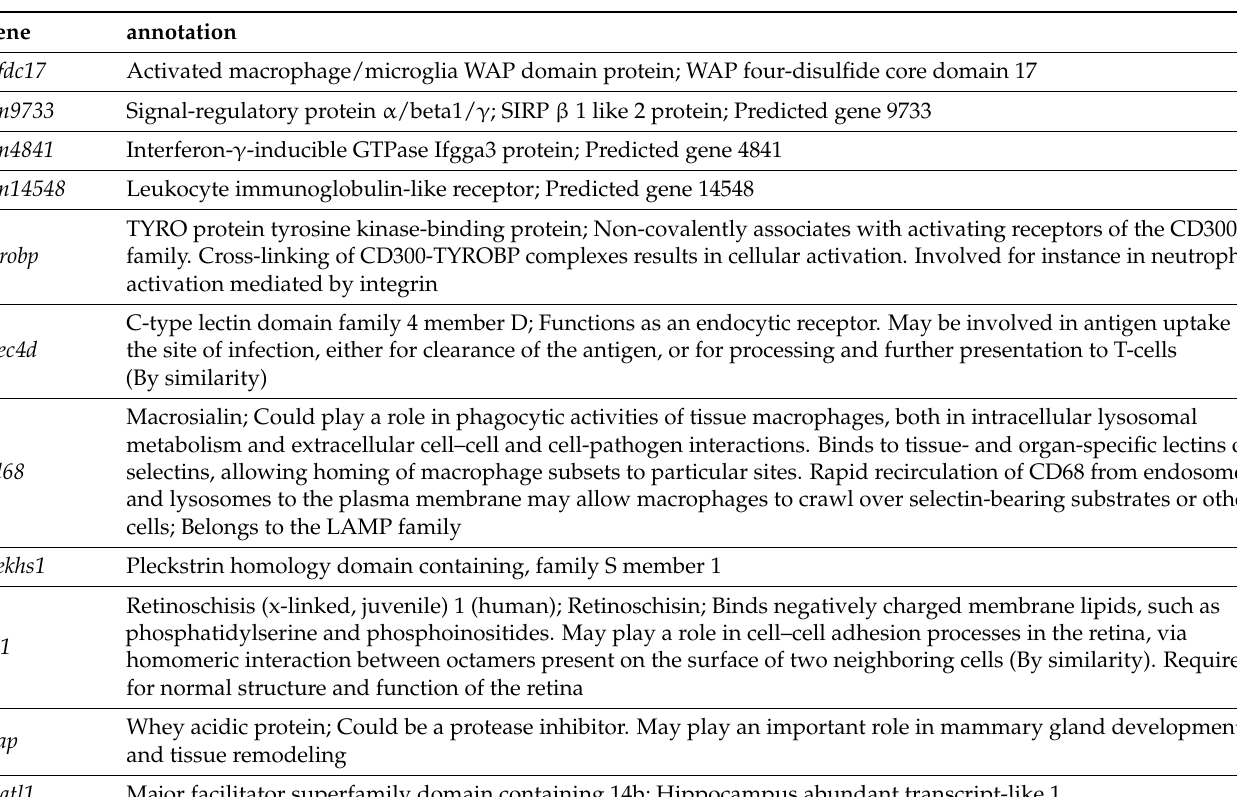
Table 3. Functional annotation of Wfdc17 protein association network.